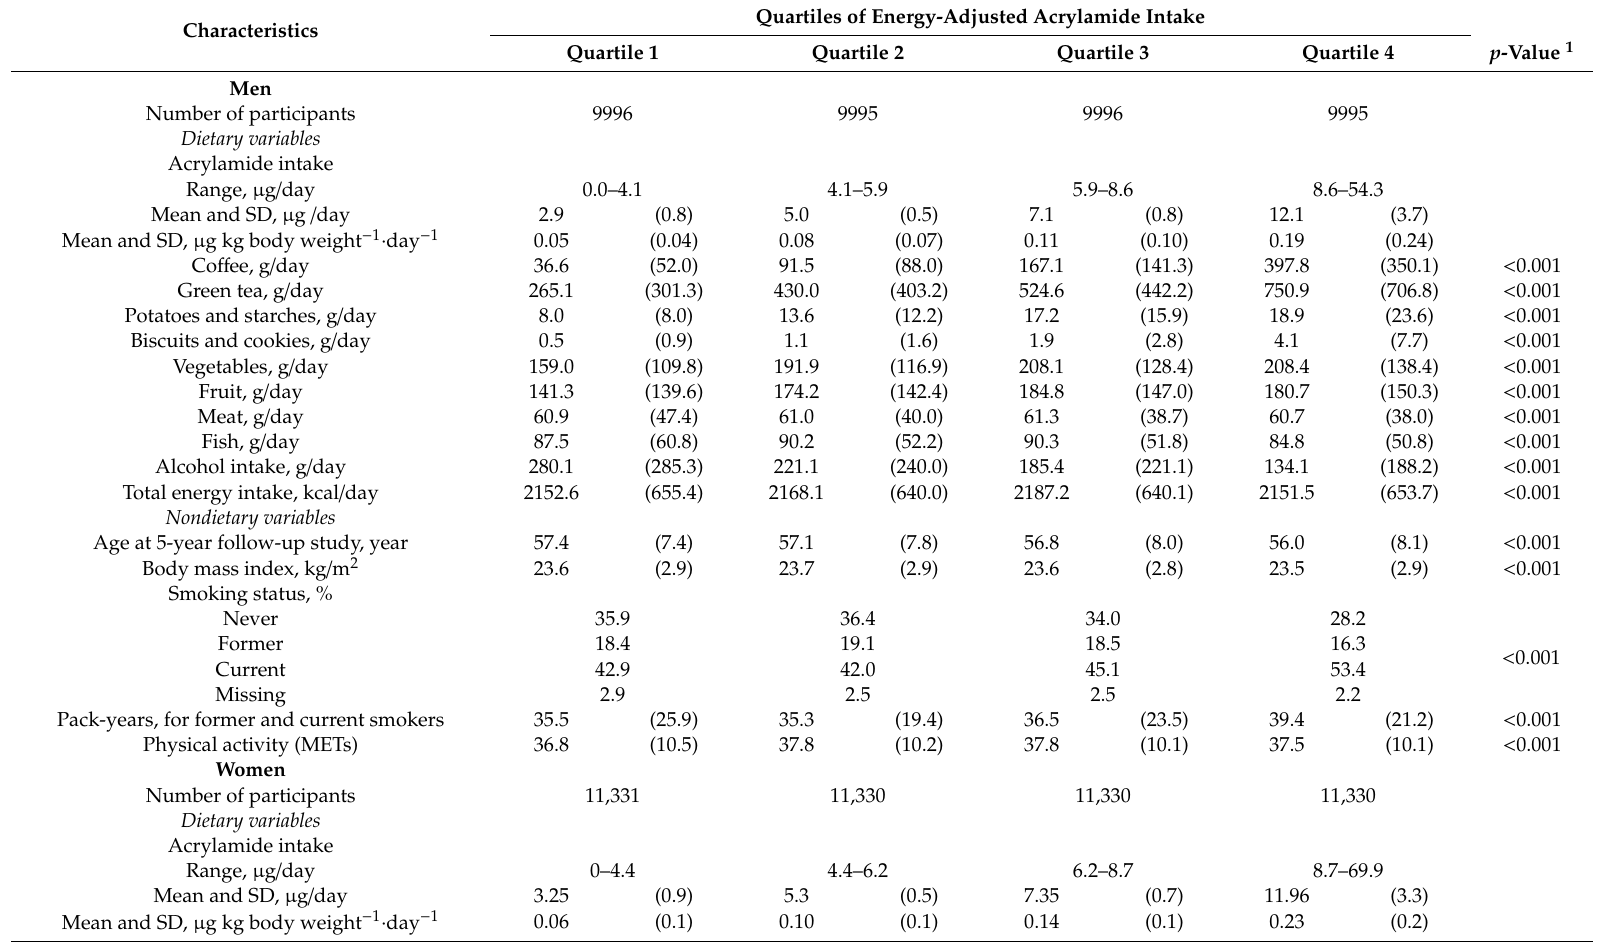
Table 1. Characteristics of participants ( n = 85,303) in the lung cancer